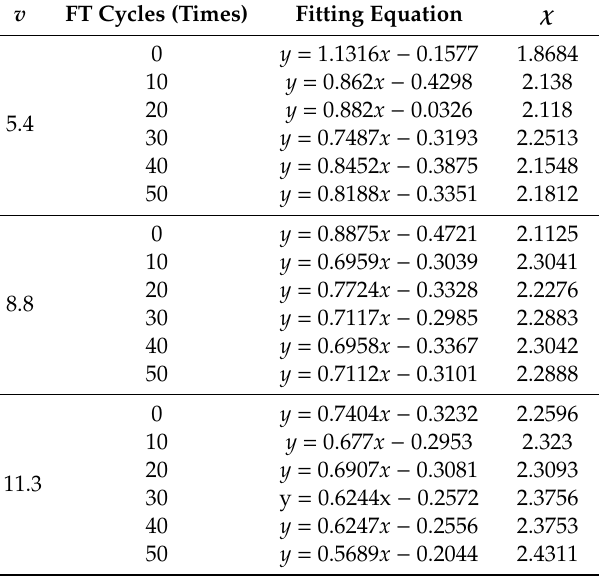
Figure 6. Logarithmic curves of the concrete crushing blocks. ( a ) 5.4 m / s; ( b ) 8.8 m / s; ( c ) 11.3 m / s. Table 1. Fractal dimensions of crushing blocks under different conditions.